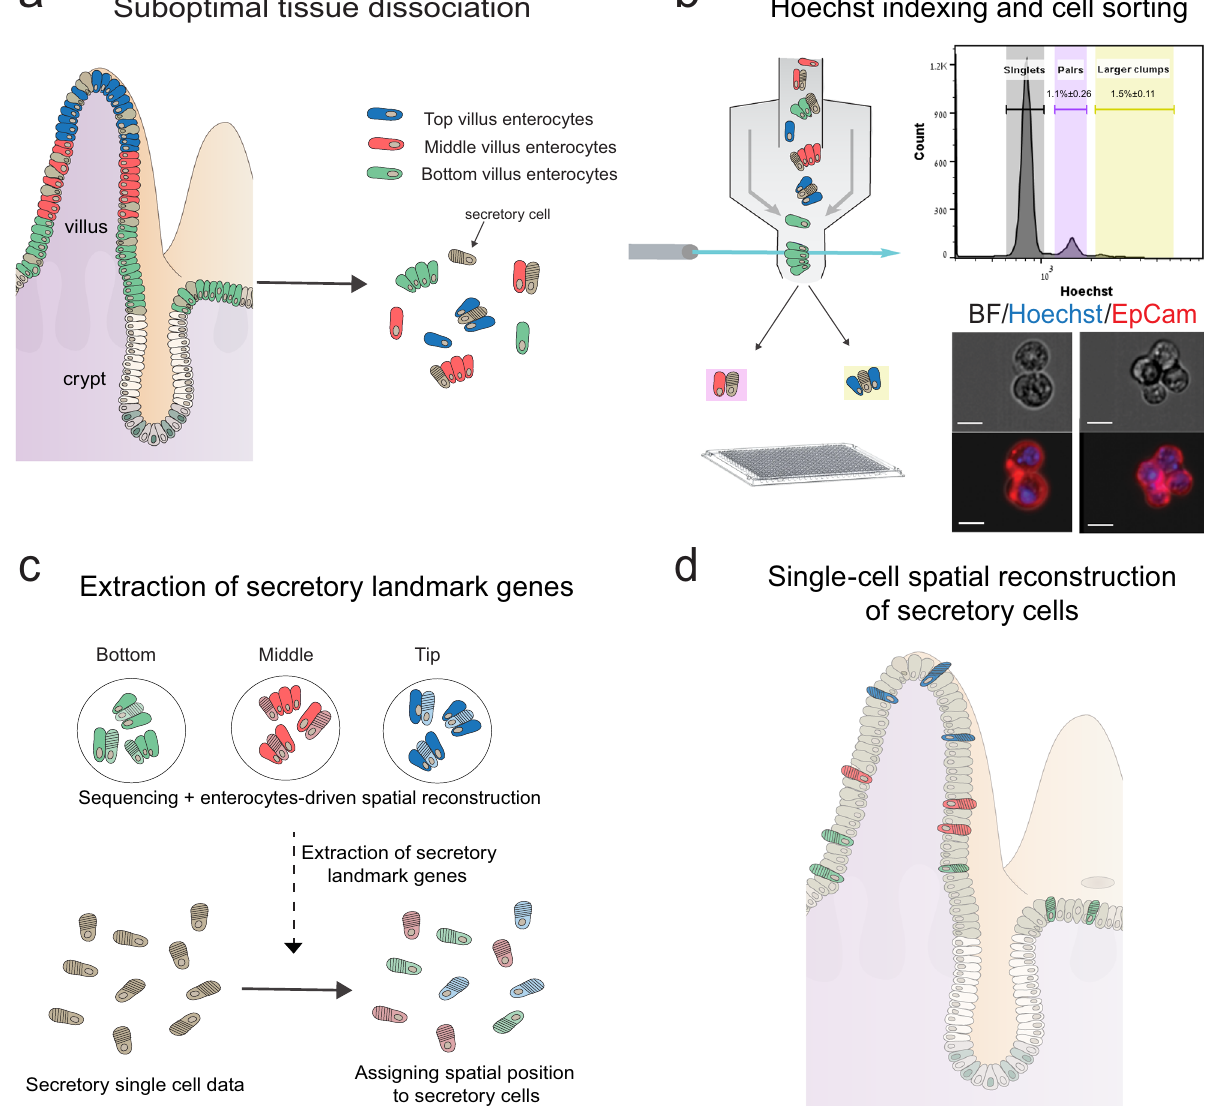
Fig. 1 Schematic representation of the experimental design. a The intestinal tissue is suboptimally dissociated to generate clumps. b Clumps are enriched with FACS, based on Hoechst DNA staining; the histogram shows ImageStream quanti fi cation of the clumps ’ nuclear DNA content ( n = 3 mice). Source data are provided as a Source data fi le; bottom shows an example of a pair (left) and a 4-cell clump (right). Scale bar, 10 μ m. c The position of clumps is computationally inferred by the enterocyte transcriptome, and spatial landmark genes for speci fi c secretory cells are retrieved. d These are used to infer the location of single sequenced secretory cells, enabling zonation